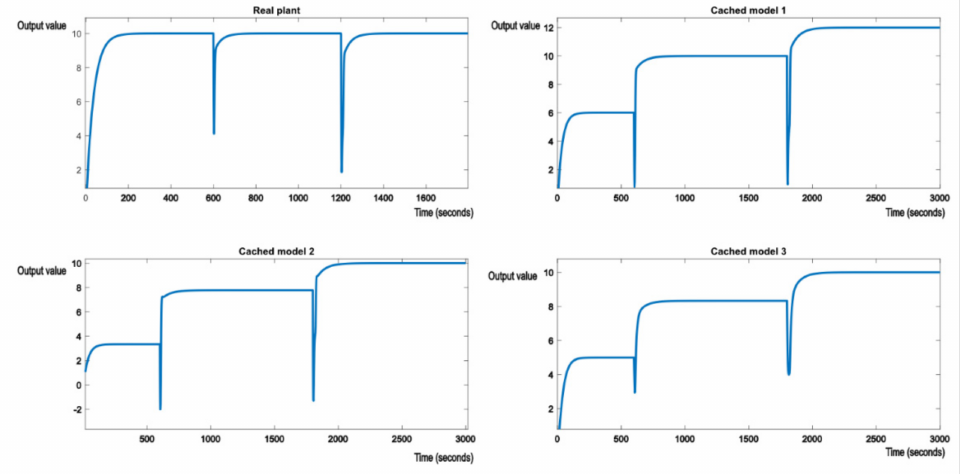
Figure 11. Switching from the initial model to cached model 1 and then to cached model 2.